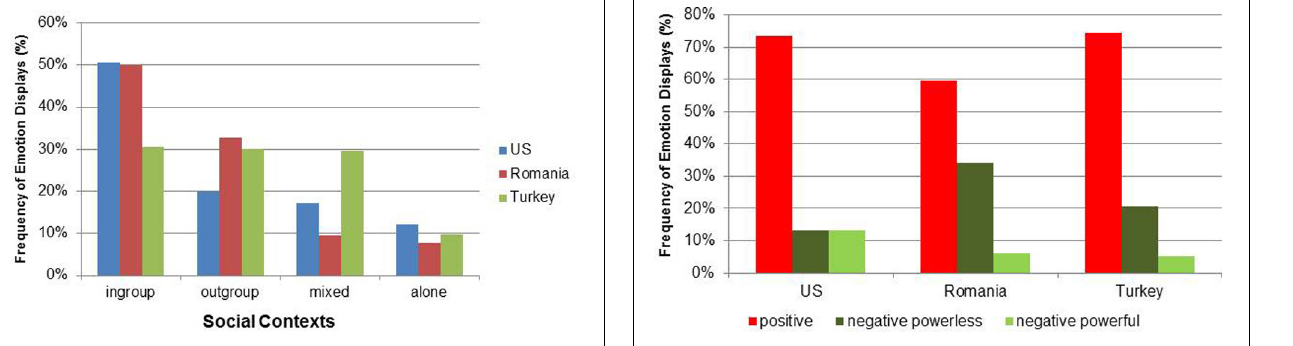
FIGURE 1 | Distribution of social contexts for the three cultural